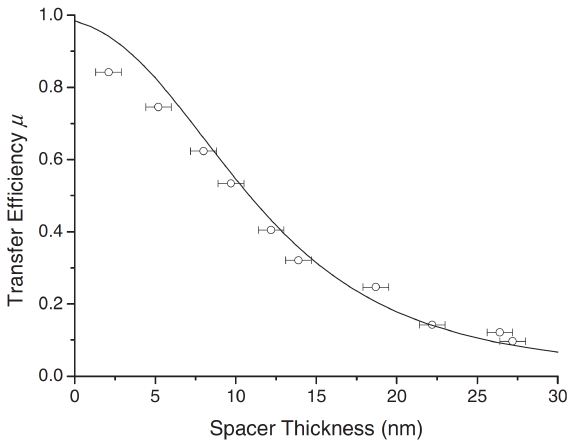
Figure 7. Energy transfer efficiency as a function of spacer thickness for a PFOBT–P3HT system. Reprinted with permission from [101]. Copyright 2008 by The American Physical